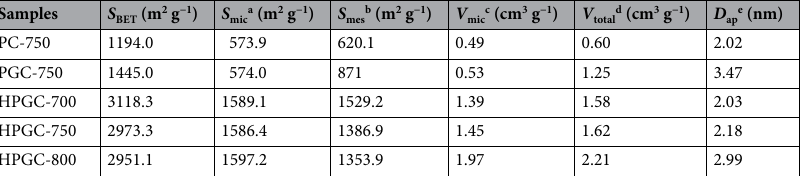
Table 1. Porosity properties of as-prepared carbon samples. a Micropore surface area. b Mesopore surface area. c Micropore volume. d Total pore volume. e Average pore size.